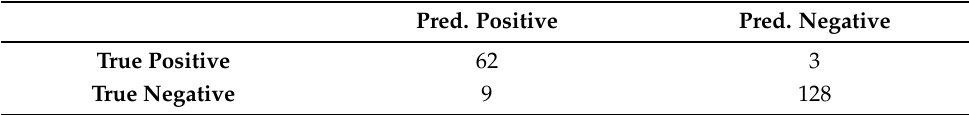
Figure 6. Distribution of the classification results. Table 4. Confusion matrix for the entire testing set: CNN